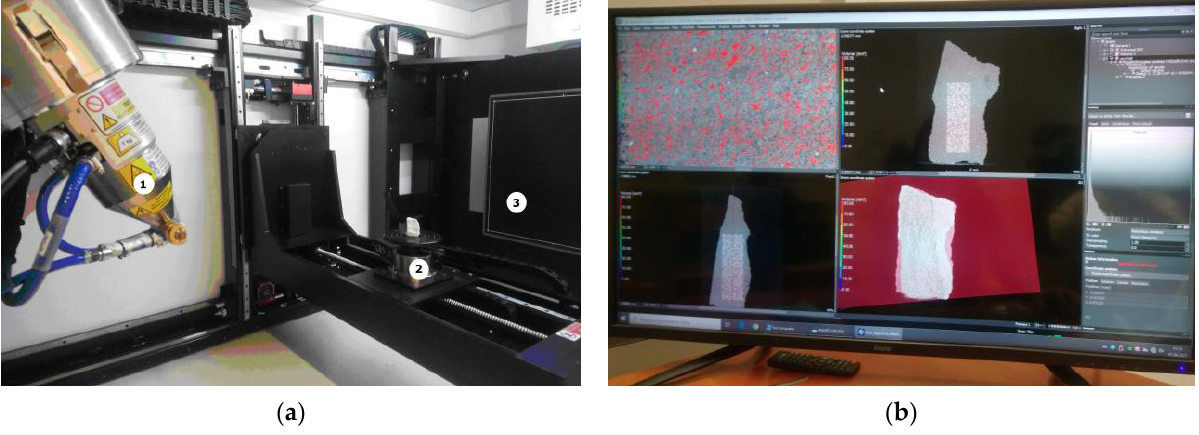
Figure 4. The method of performing the examination with the use of a computer tomograph. ( a ) Test method. Micro-CT analysis (1—reflection lamp, 2—rotary table with the sample, 3—detector). ( b ) Analysis of the sample in VG Studio